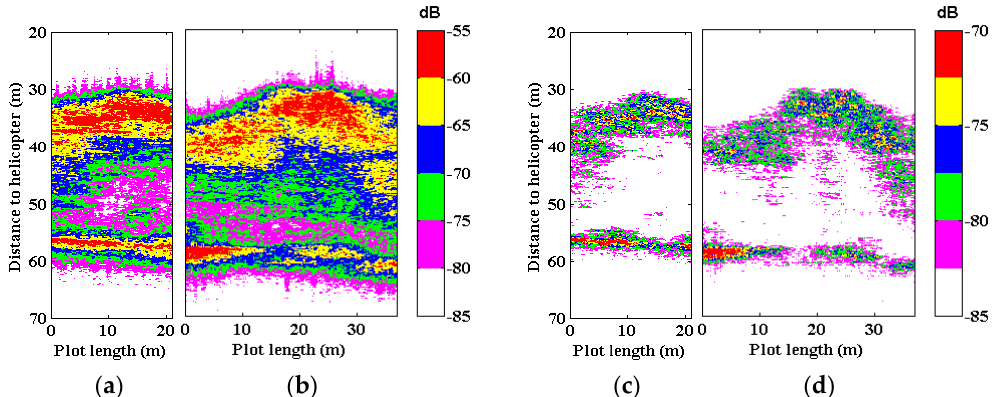
Figure 5. The Tomoradar vertical profiles of the selected plots in co- and cross- polarization, which are colored with backscattering energy intensity. ( a ) Co-polarization vertical profile of plot 1; ( b ) co-polarization vertical profile of plot 2; ( c ) cross-polarization vertical profile of plot 1; ( d ) cross-polarization vertical profile of plot 2. 1; ( d ) cross-polarization vertical profile of plot 2.